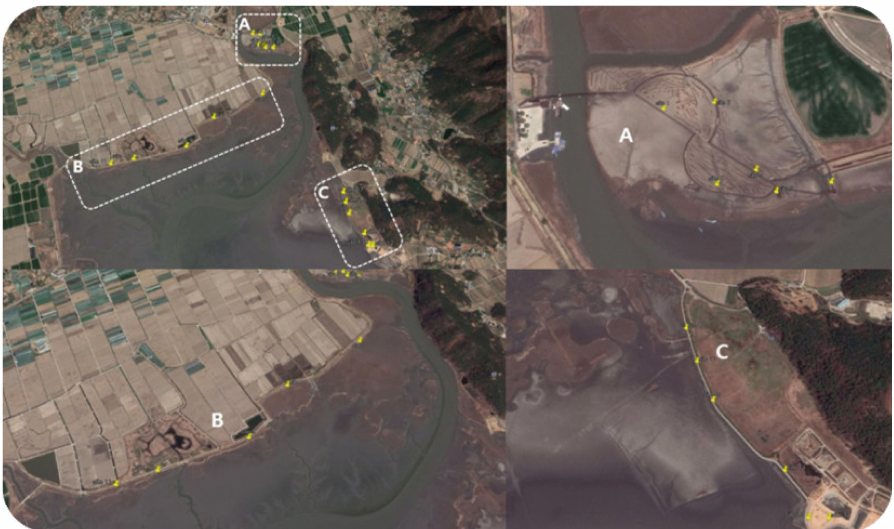
Figure 2. Aerial view of each sampling site (indicated in yellow). Salt marshes developed in ( A ) the delta of Suncheon Bay ( Phragmites australis colonies at six sampling sites), ( B ) tidal flats (five sites of P. australis colonies), and ( C ) tidal flats (six sites of Suaeda japonica colonies). The aerial images were collected using Google Earth (version 7.3.3) and modified for this study. Table 1. Description of the sampling sites at each salt marsh and endophytic culture collection. Host Sampling Species